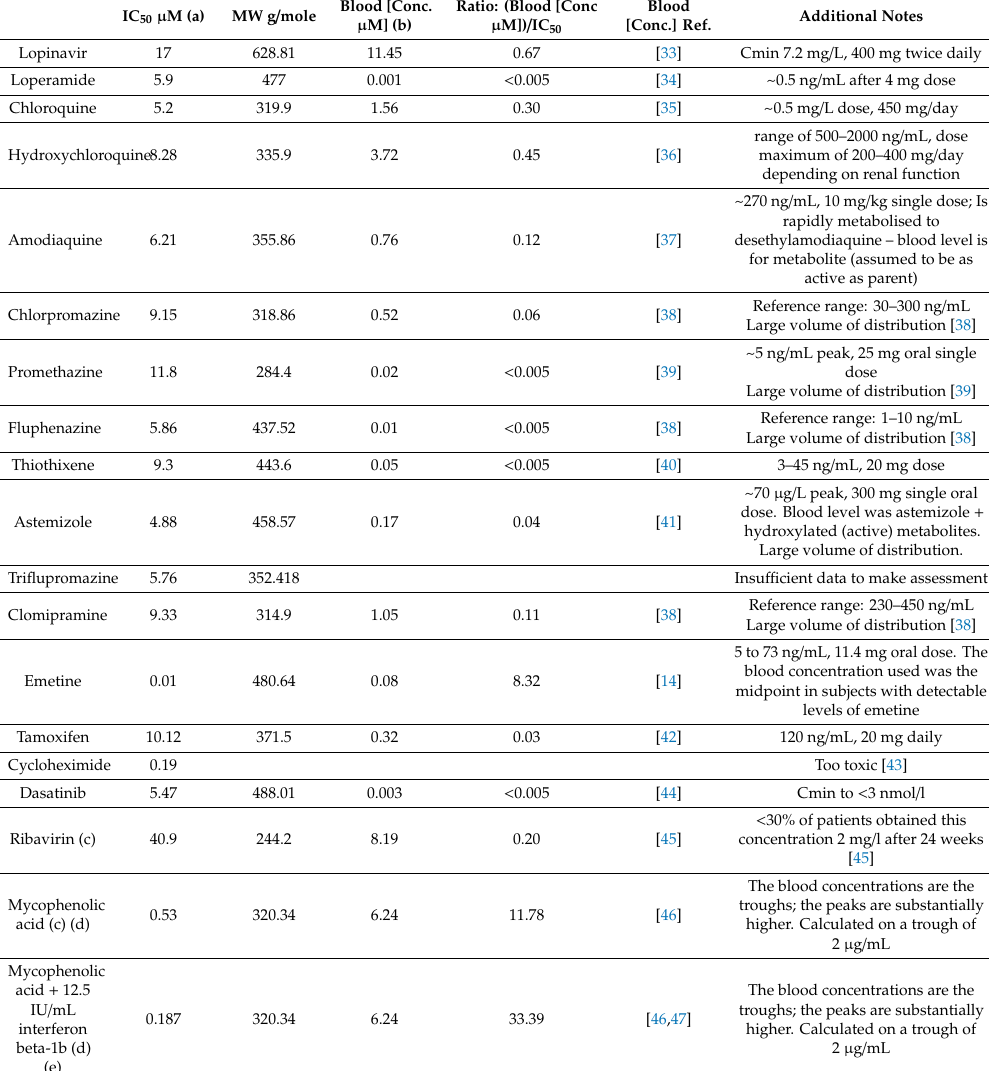
Table 1. Inhibitory activities of the reported MERS-CoV replication inhibitors available in the FDA-approved drug register (adapted from Liu 2015 [2]) with approximate therapeutic blood concentrations and corresponding ratio of blood concentration and IC 50